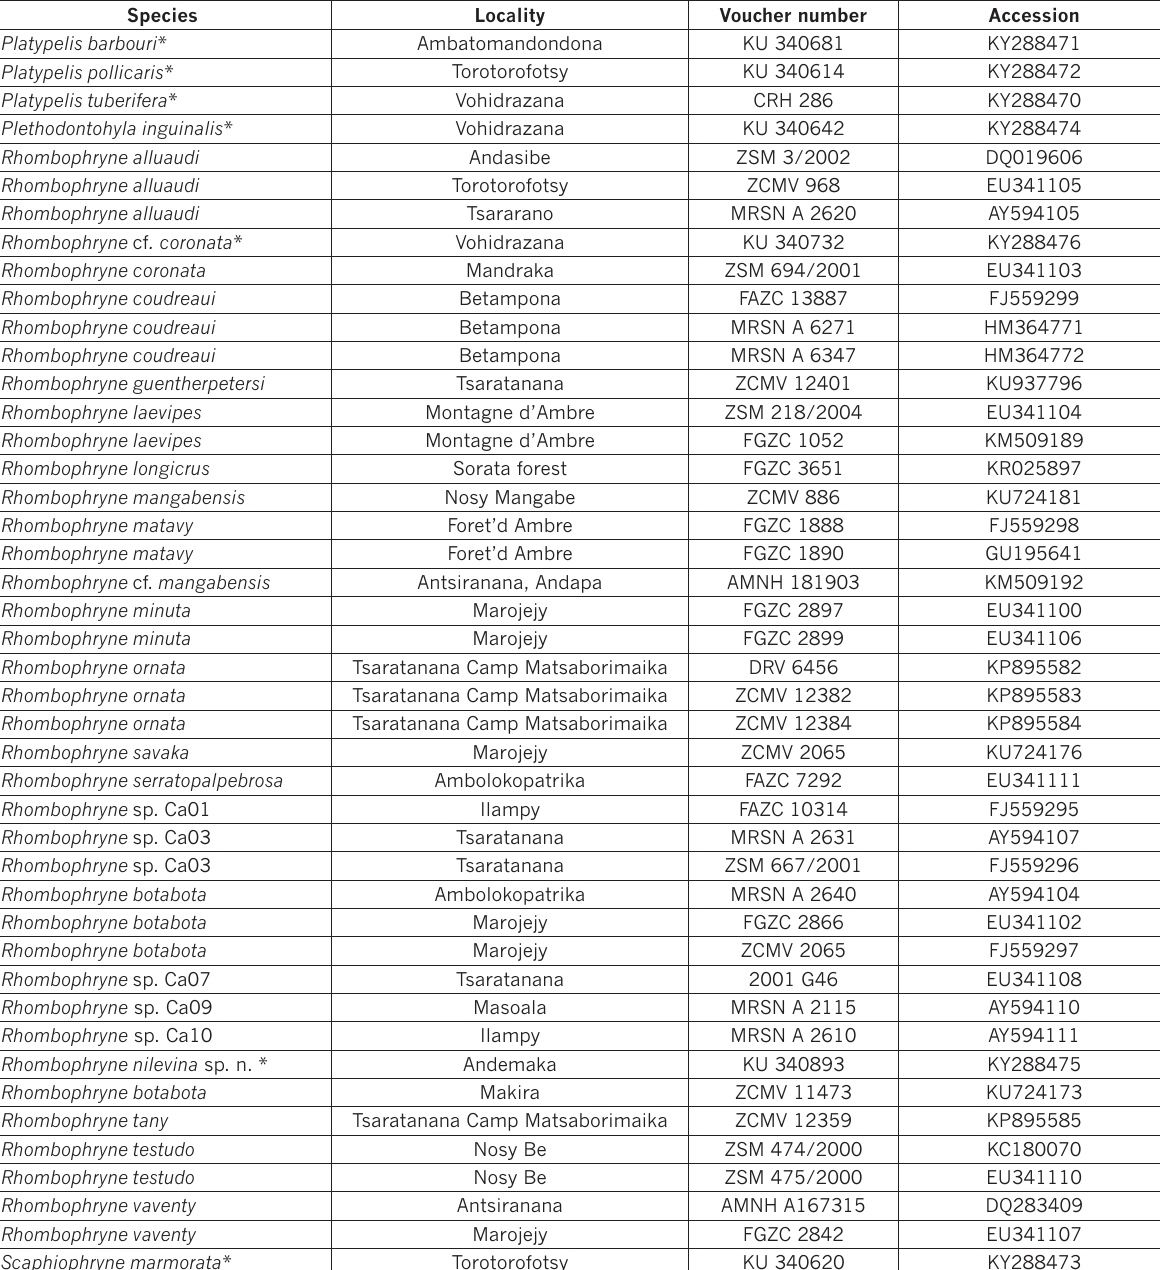
Table 1. GenBank Accession numbers for all sequences used in phylogenetic analysis. Asterisks indicate newly generated